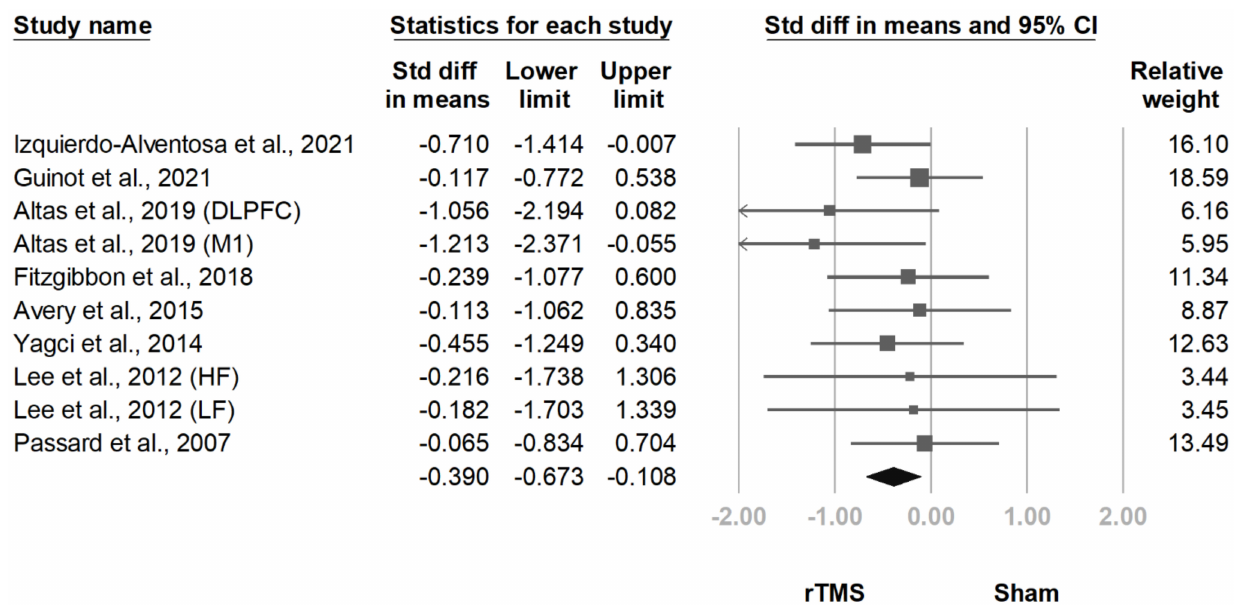
Figure 15. Forest plot of standardized mean differences in Beck Depression Inventory after treatment. Squares indicate effect sizes of individual studies, lines indicate 95% CI, and diamond indicates the summarized effect size.